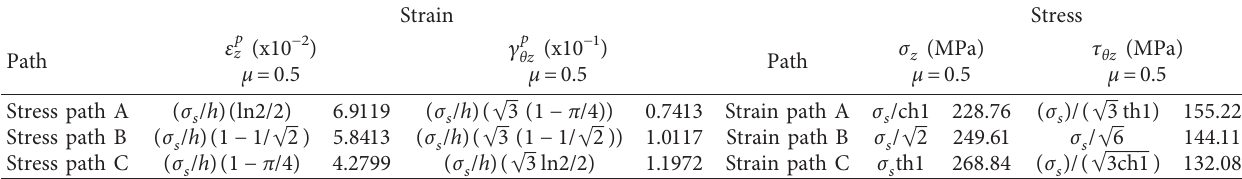
Table 4: The theoretical calculation results under different stress/strain loading